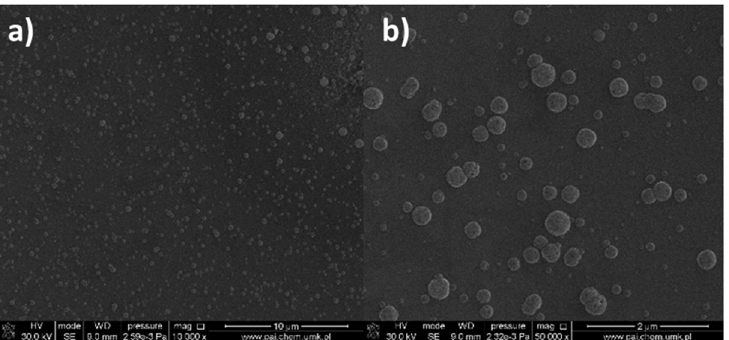
Figure 20. SEM images of [Cu 2 (EtNH 2 ) 2 (µ-O 2 CC 3 F 7 ) 4 ] ( 3 )/Si after heating, ( a ) Mag = 10,000×, ( b ) Mag = 50,000× .